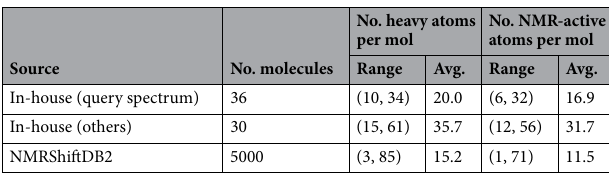
Table 1. Summary statistics of candidate